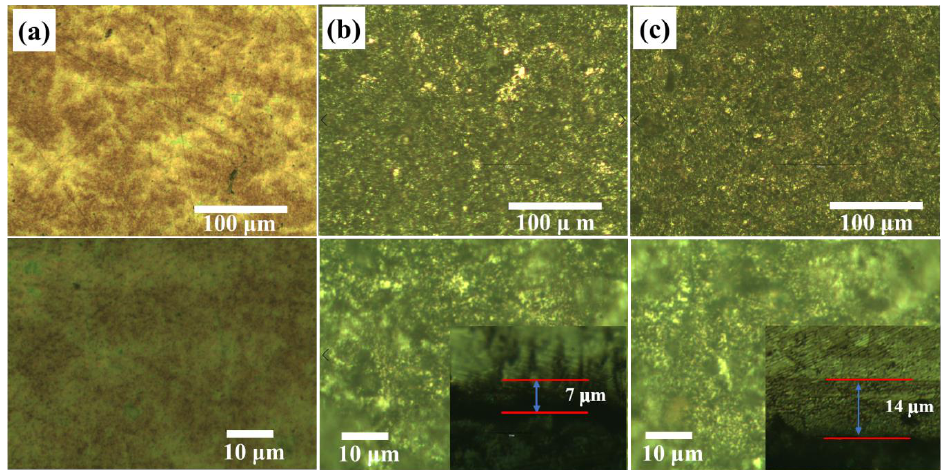
Figure 2. OM surface morphologies and cross-sectional microstructures of the samples ( a ) S1, ( b ) S2, and ( c ) S3.